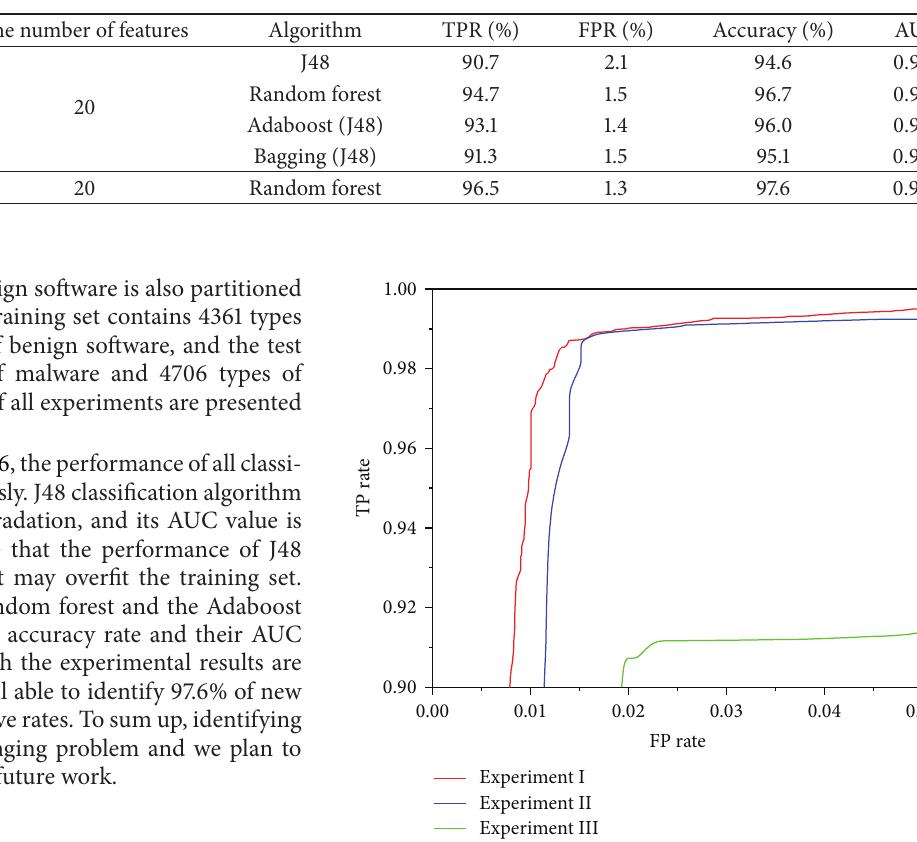
Figure 3: ROC curves for J48 classification